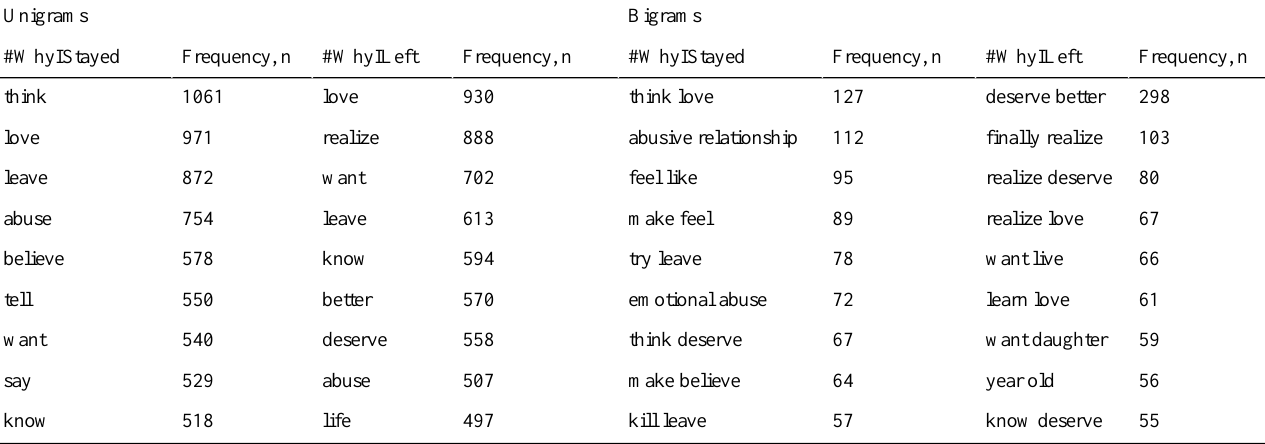
Table 3. Top 9 most frequent unigrams (left) and bigrams (right) after preprocessing, with their respective frequencies in the Twitter devset.